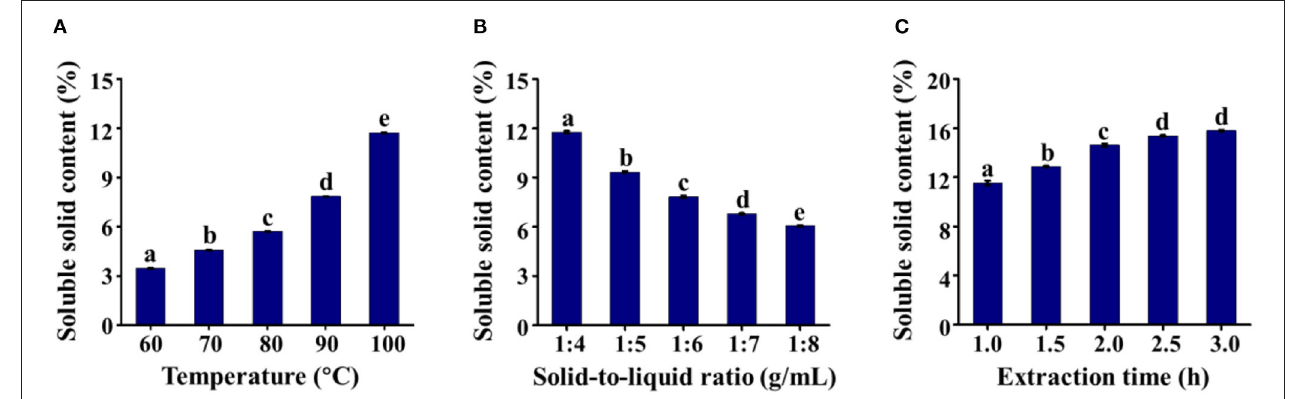
FIGURE 1 | The soluble solid contents of black garlic extracts under different (A) extraction temperatures, (B) solid-to-liquid ratios, and (C) extraction times. Data are means ± SD ( n = 3).